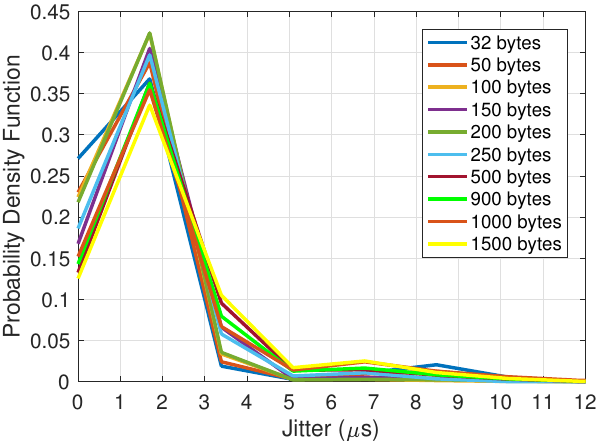
Figure 7. Distribution of jitter on the fronthaul for different packet sizes.